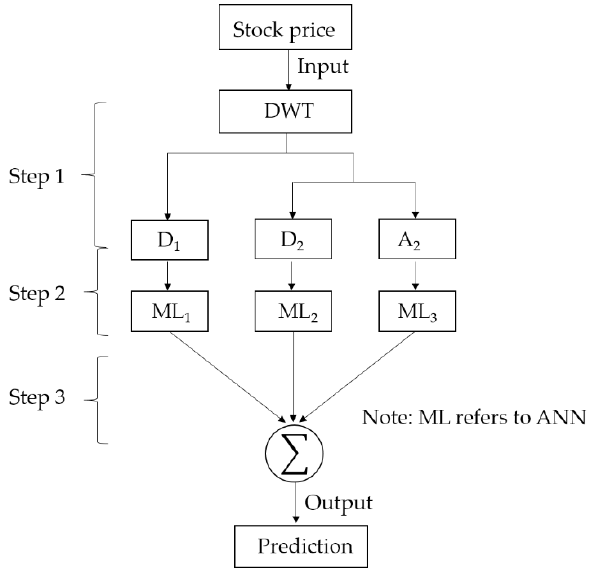
Figure 3. Overall process of the DWT-based model.